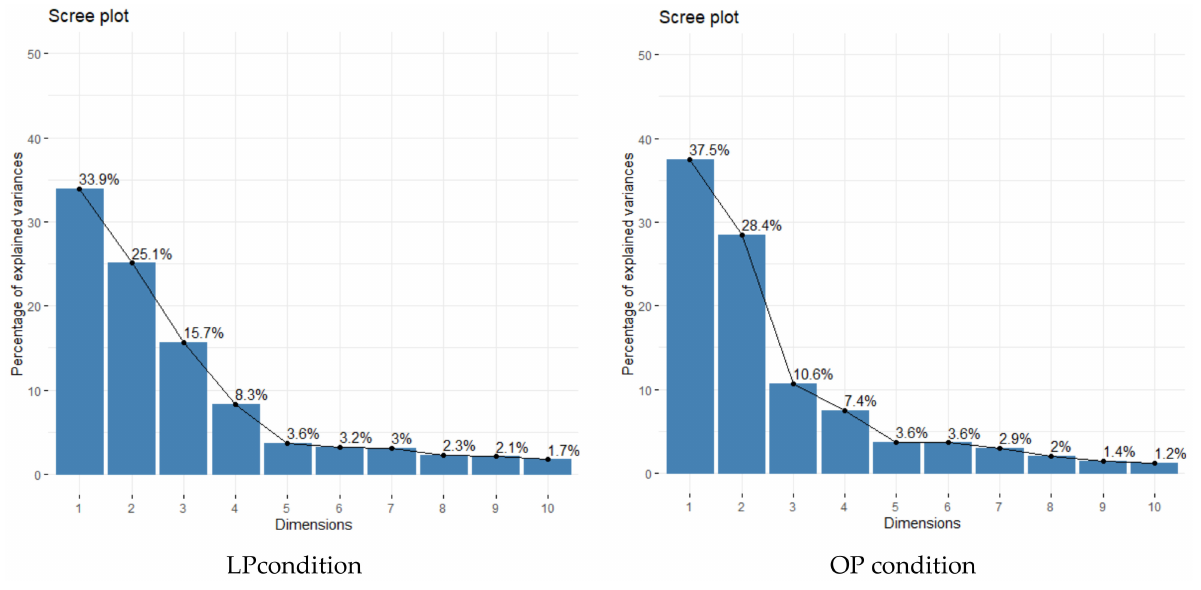
Figure 3. Scree plot under LP and OP conditions.